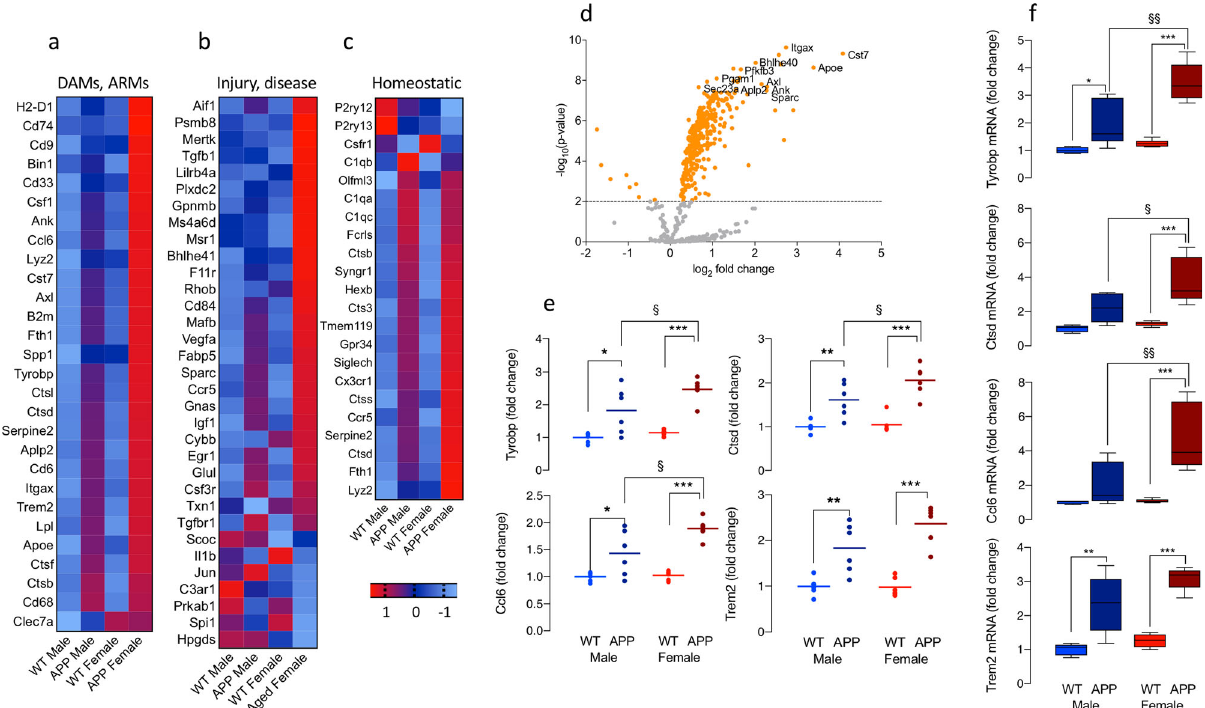
Fig. 1 Sex-related differential expression of microglial markers in APP/PS1 and WT mice. a – c The heat maps, generated from a Nanostring quantitative assay platform, represent the experimental groups and individual mRNA transcripts in columns and rows, respectively. Genes that have been reported to be upregulated in ARMs and/or DAMs ( a ) or in other neuroin fl ammatory conditions ( b ) and genes that describe the homeostatic state ( c ), are shown. Expression is displayed on a log 10 scale from blue (low expression) to red (high expression). d Volcano plots of mRNA expression showing signi fi cant genotype-related differences ( p < 0.01 indicated by the dotted line) are depicted. e , f Signi fi cant genotype × sex interactions in Tyrobp and Ccl6 ( p < 0.05) and signi fi cant main effects of genotype ( p < 0.001) and sex ( p < 0.05 or p < 0.01) were identi fi ed in mean data from Nanostring analysis and RT-PCR for Tyrobp, Ctsd, Ccl6 , and Trem2 . Post hoc analysis revealed signi fi cant genotype-related increases (* p < 0.05; ** p < 0.01) and signi fi cant increases in Tyrobp, Ctsd , and Ccl6 in microglia from female, compared with male, APP/PS1 mice ( § p < 0.05; §§ p < 0.01; §§§ p < 0.001) and in several other indicators of microglial activation as indicated in Supplementary Fig. 1. Data, expressed as means ± SEM ( n = 5 (PCR data) or 6 (Nanostring data)), were analysed by 2- way ANOVA and Tukey ’ s post hoc multiple comparison test. The changes in e and f are relative to values in WT males. Additional related data are presented in Supplementary Figs. 1 and